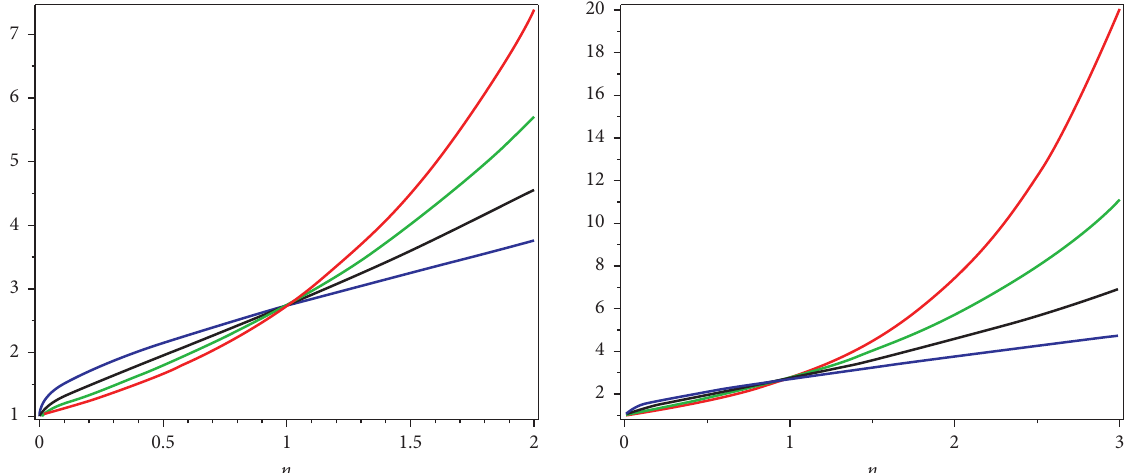
Figure 6: The different fractional-order graphs of problem 4.2, with respect to